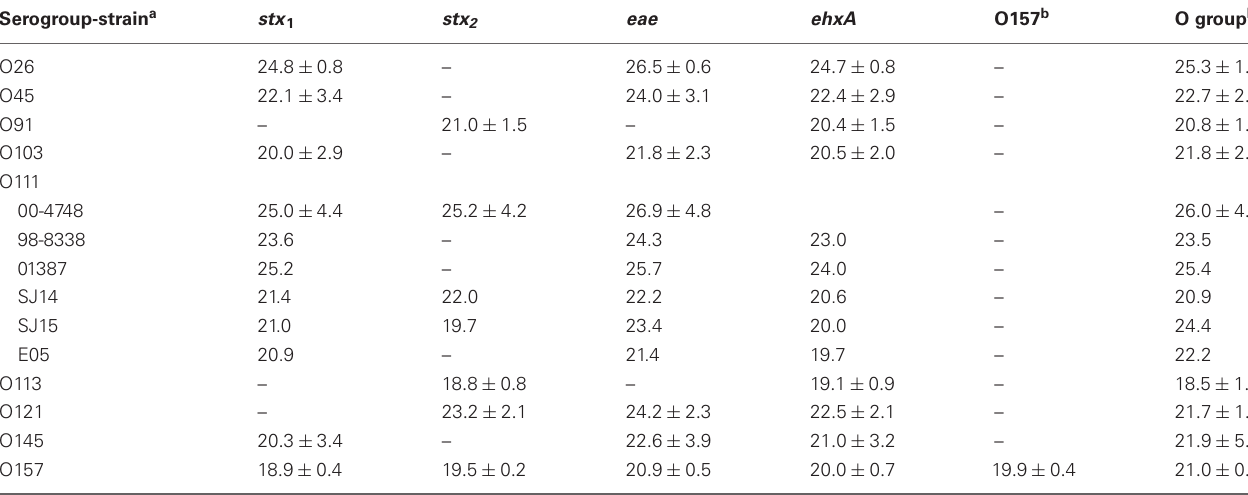
Table 2 | Average cycle thresholds ± STDEV of GeneDisc assays using mTSB for enrichment of ground beef samples. Serogroup-strain a stx 1 stx 2 eae